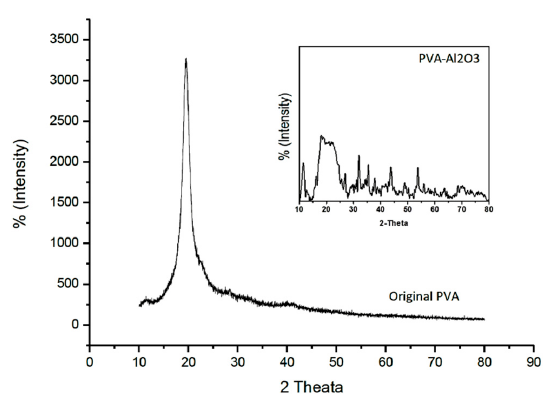
Figure 5. XRD pattern of virgin PVA and PVA-Al 2 O 3 nanocomposite.